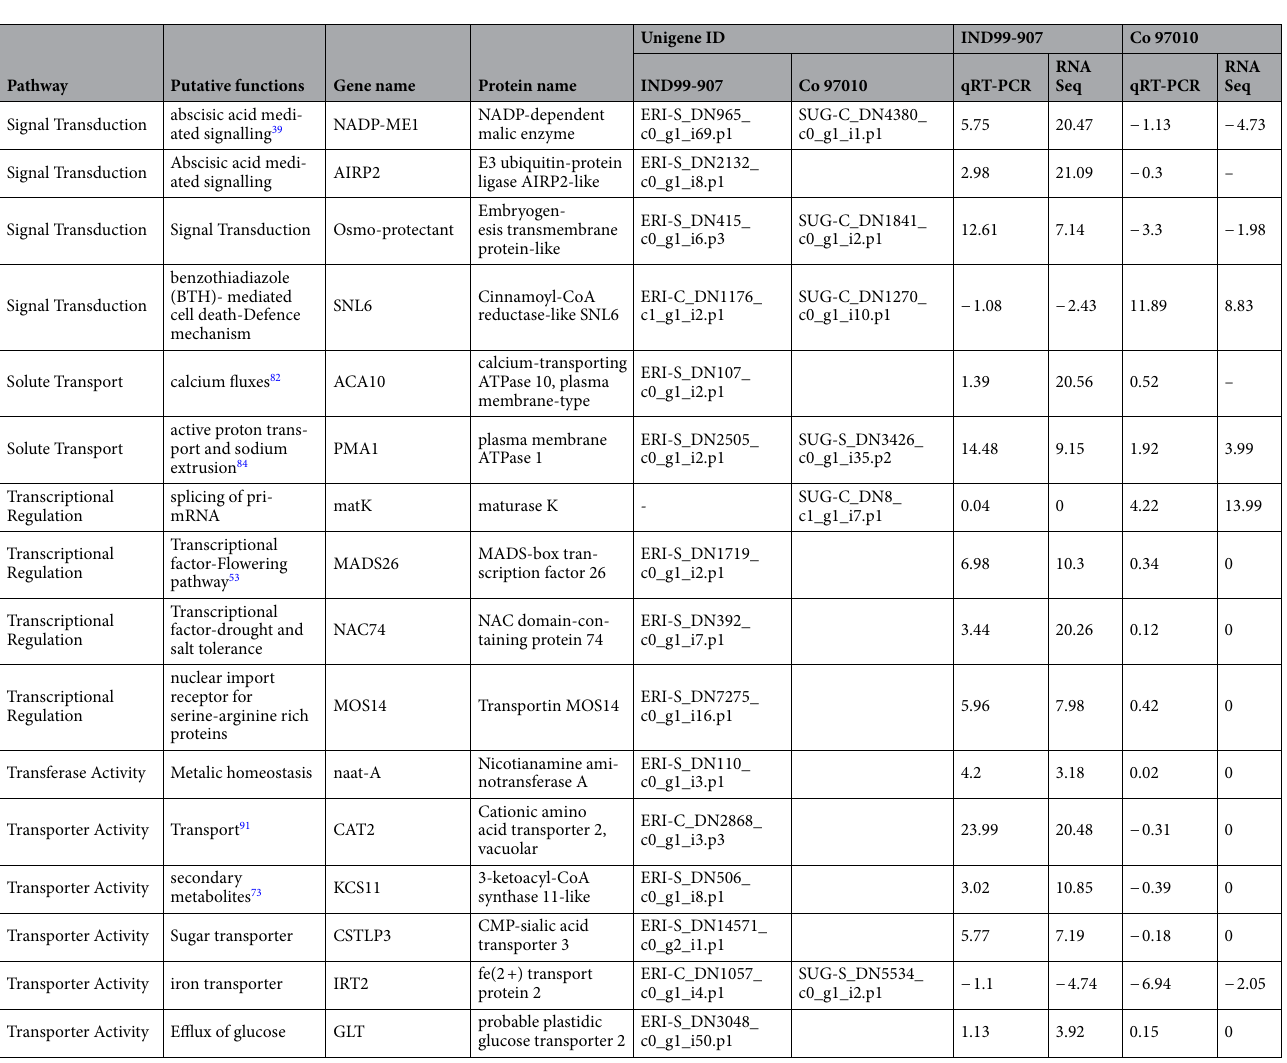
Table 2. Validation of candidate genes through